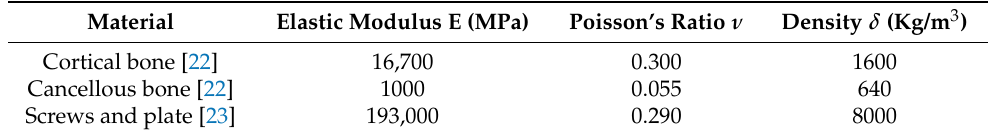
Table 3. Components material properties.